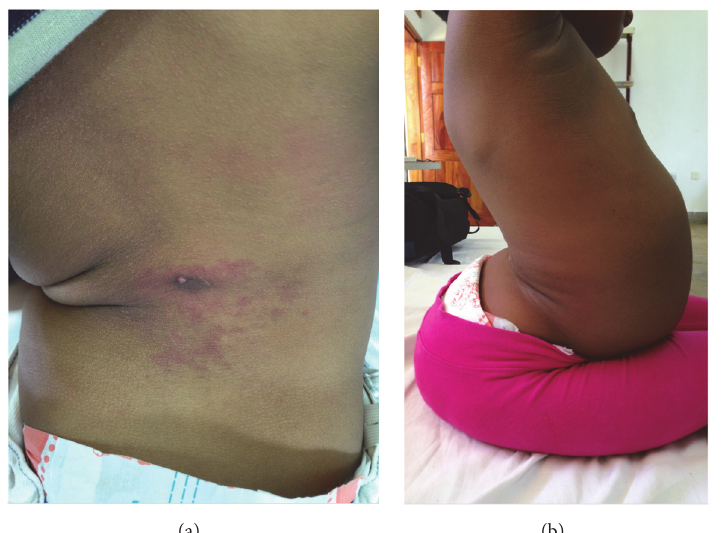
Figure 3: Physical examination demonstrated (a) the midline papule, a thoracolumbar scoliosis, and (b) marked lumbar scoliosis and lumbar